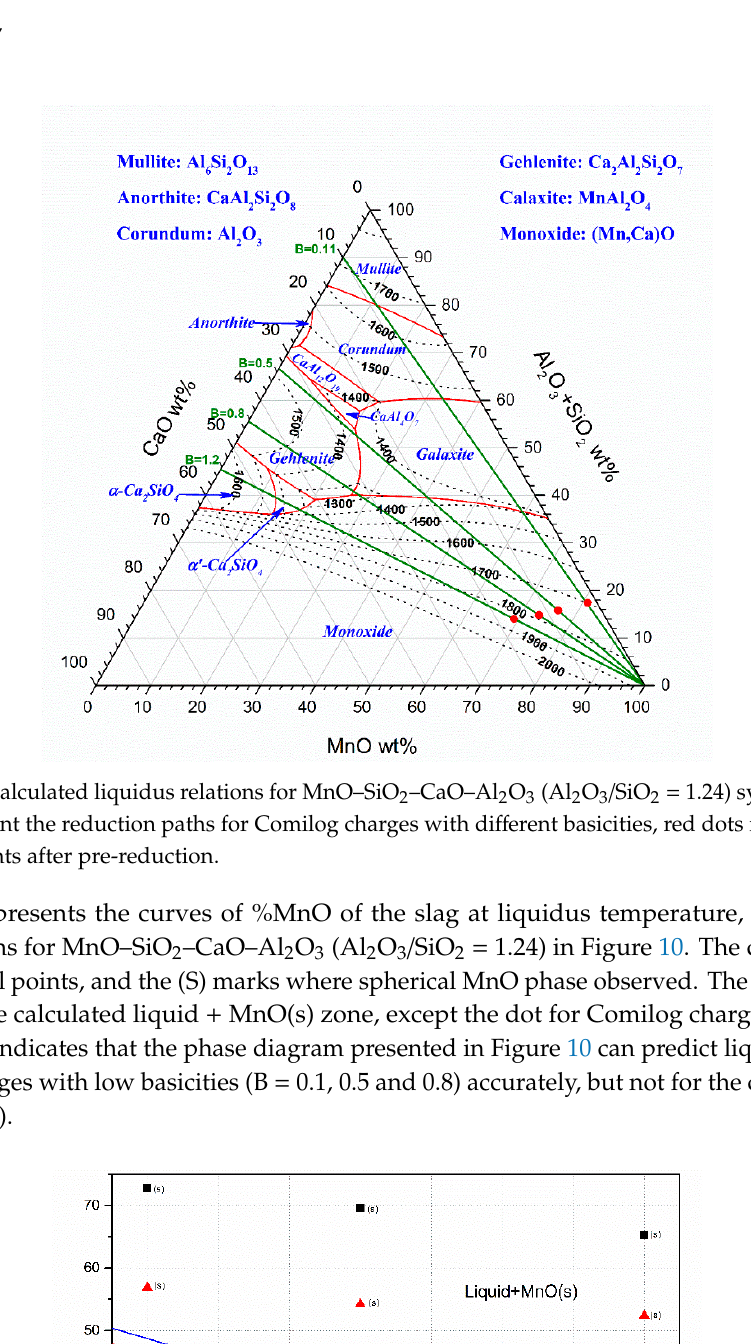
Figure 11. Curves of %MnO of the slag at liquidus temperature, calculated from liquidus relations for MnO–SiO 2 –CaO–Al 2 O 3 (Al 2 O 3 /SiO 2 = 1.24) system in Figure 10. The dots are experimental points, and the (S) marks where spherical MnO phase is observed.